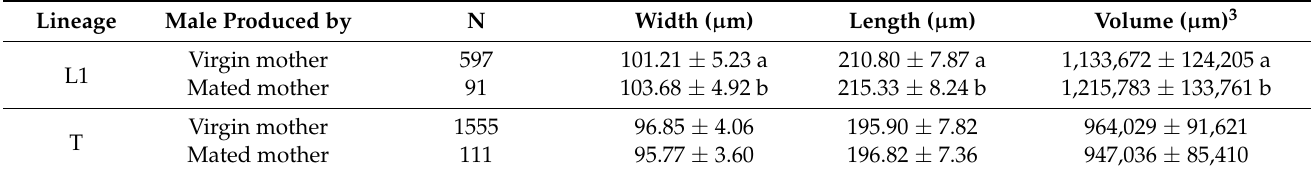
Table 6. Size of male eggs produced by virgin and mated mothers of the L1 and T lineages throughout the lifespan.